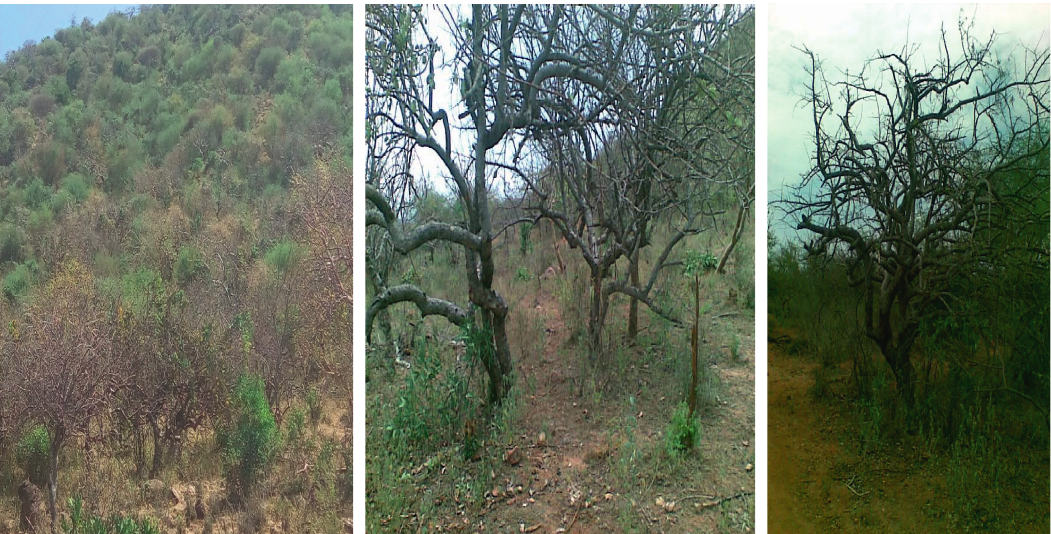
Figure 2: Gum-resin bearing trees/shrubs species stands in South Omo woodlands. Source: survey data (field photo by authors (2018/19)).